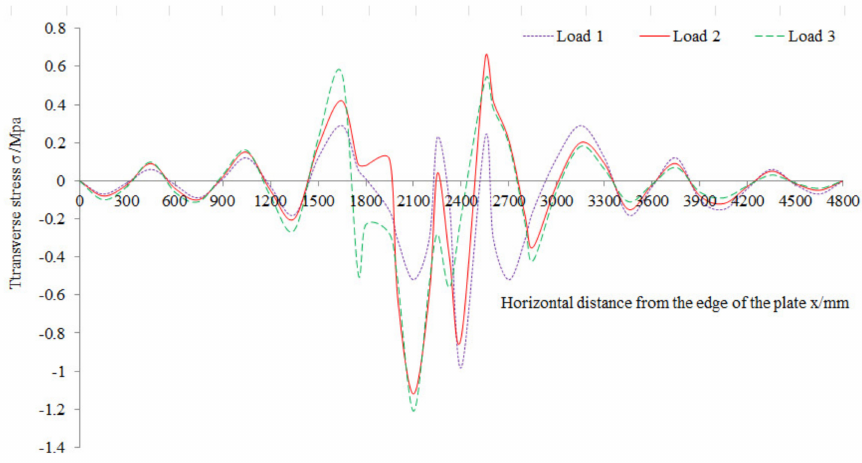
Figure 6. Transverse tensile stress distribution under different working